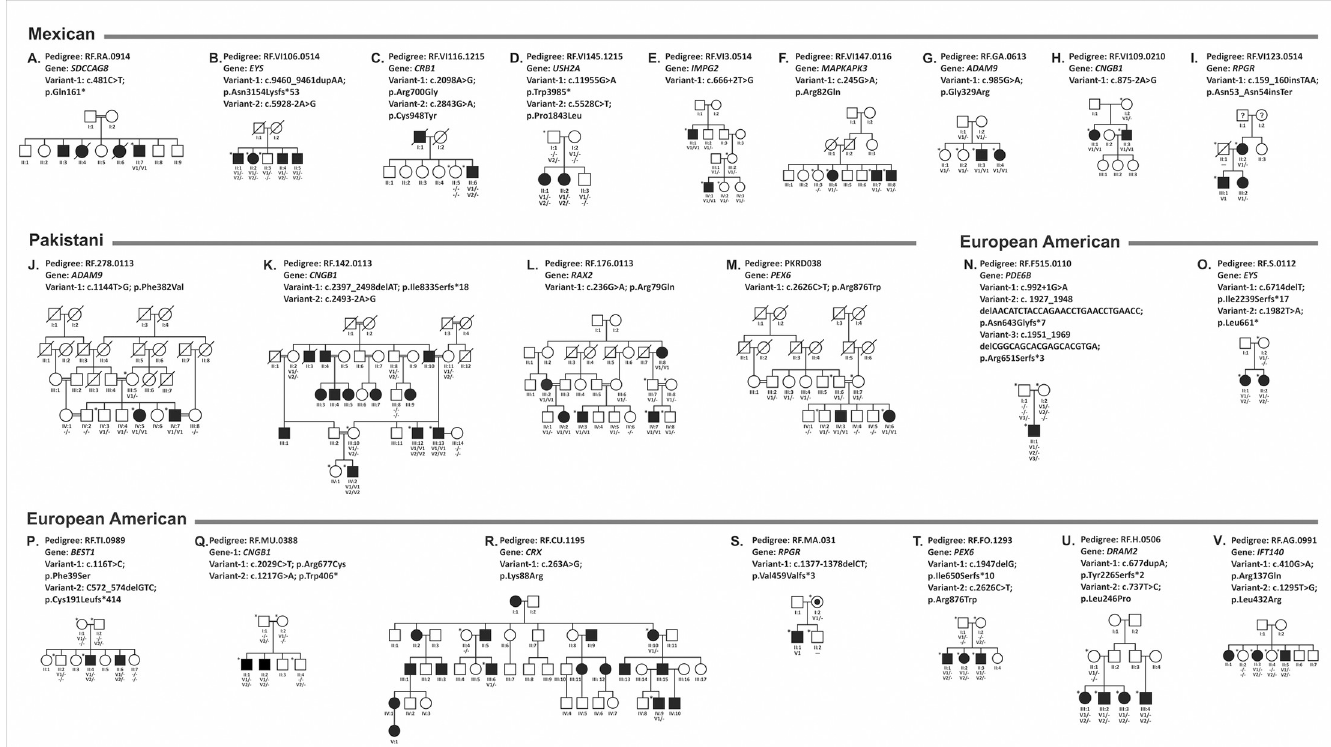
Fig 1. Pedigrees with novel mutations. The segregation analysis of 22 pedigrees showed 26 rare potentially pathogenic novel variants along with 8 previously reported mutations in 17 IRD associated genes. These include 9 homozygous, 21 compound heterozygous, two dominant acting heterozygous, and two X-linked variants. Pedigrees A-I are Mexican, J-M are Pakistani and N-V are European American. The asterisk indicates the availability of whole-genome sequencing data.